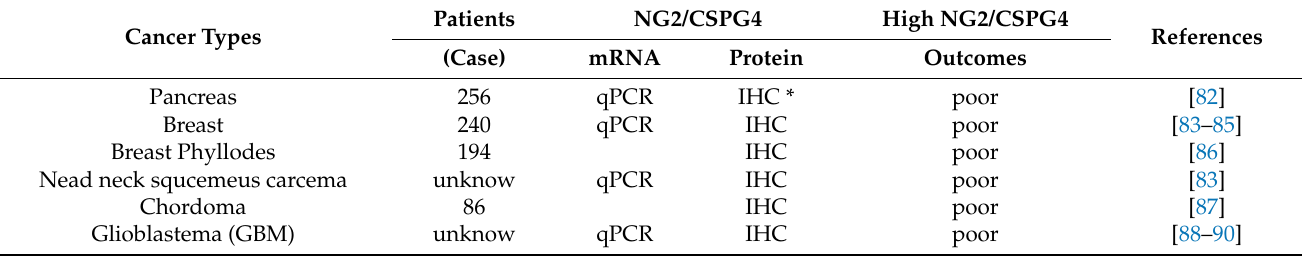
Table 1. Evaluation NG2/CSPG4 expression in solid organ cancer patients by using microcarry analysis. Cancer